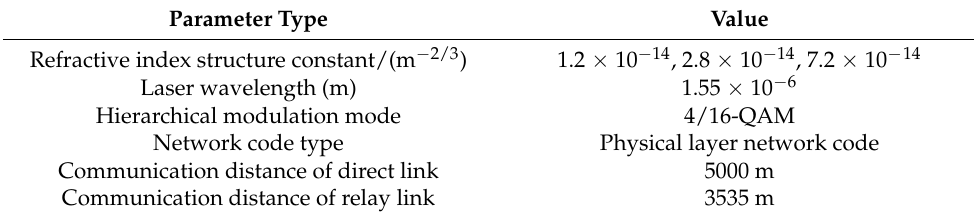
Table 1. Simulation parameter